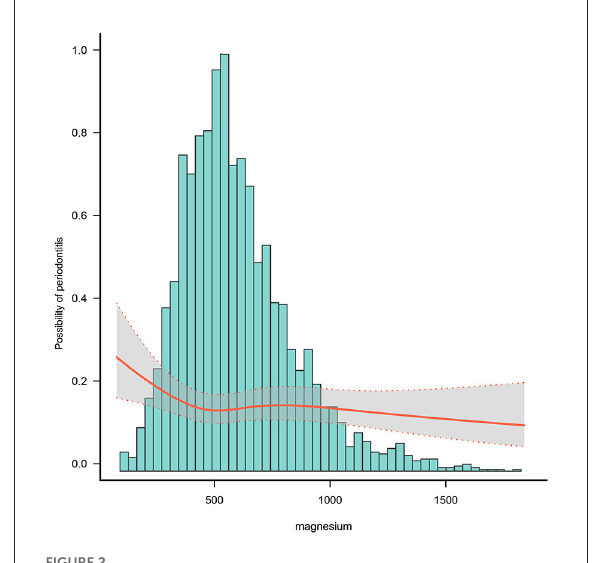
FIGURE2 Dose-response relationship of dietary magnesium with